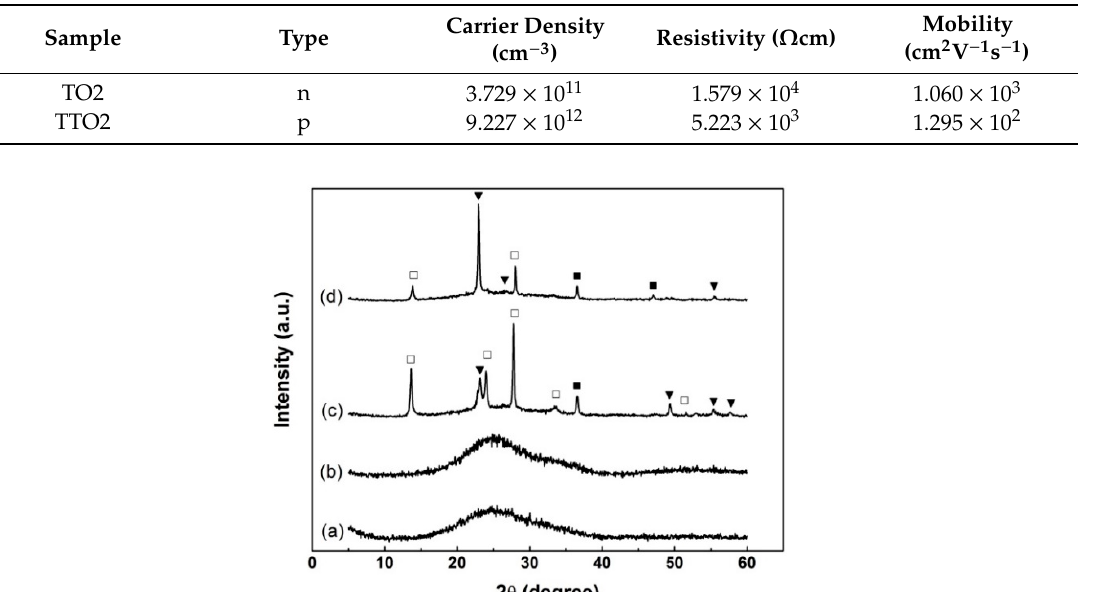
Table 1. Room temperature electrical properties of TO2 and TTO2.